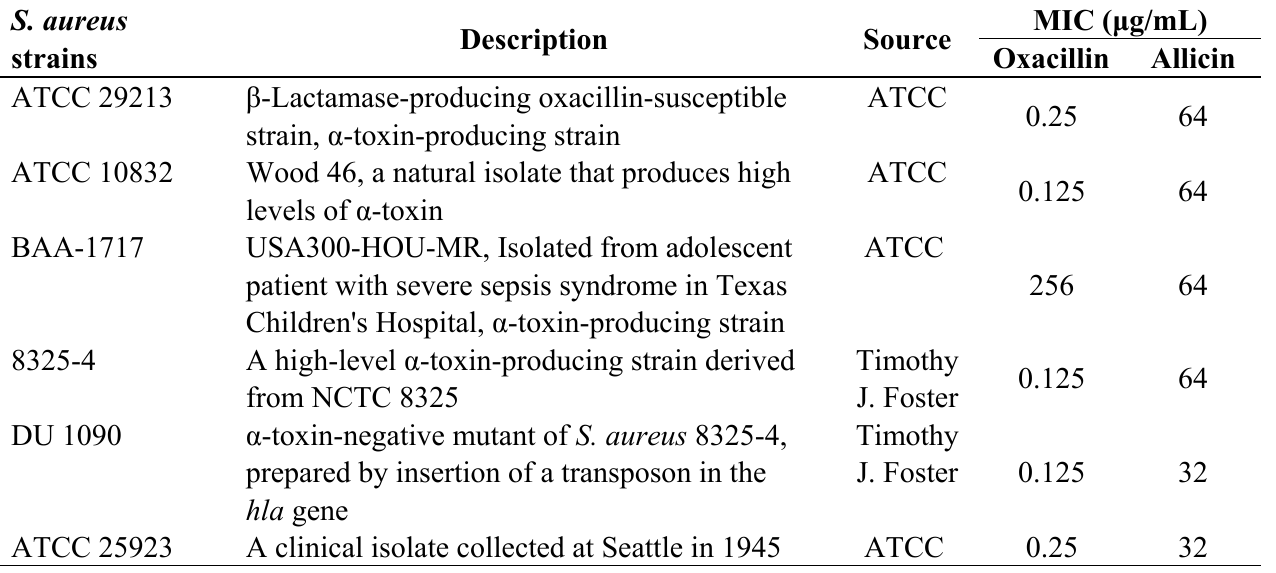
Table 1. Bacterial strains used in the study and their MICs to allicin.